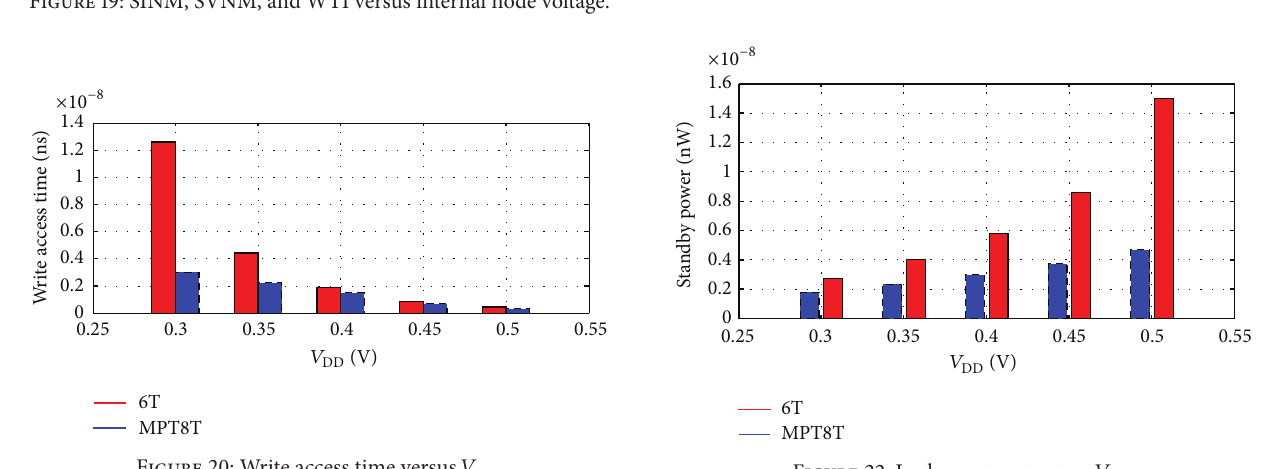
Figure 22: Leakage power versus 𝑉 DD